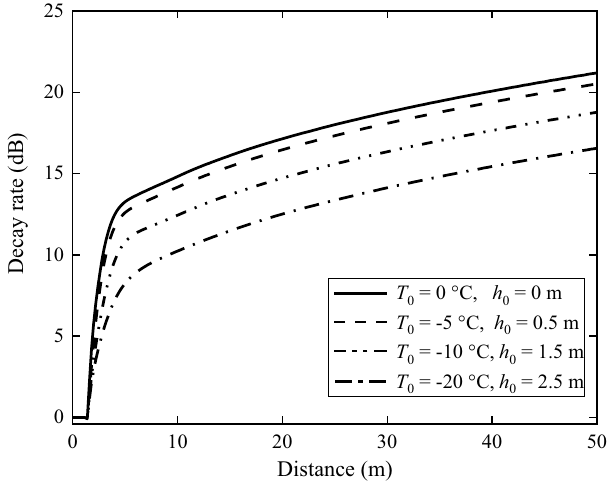
Figure 21. The decay rate of the ground along the direction perpendicular to the track.